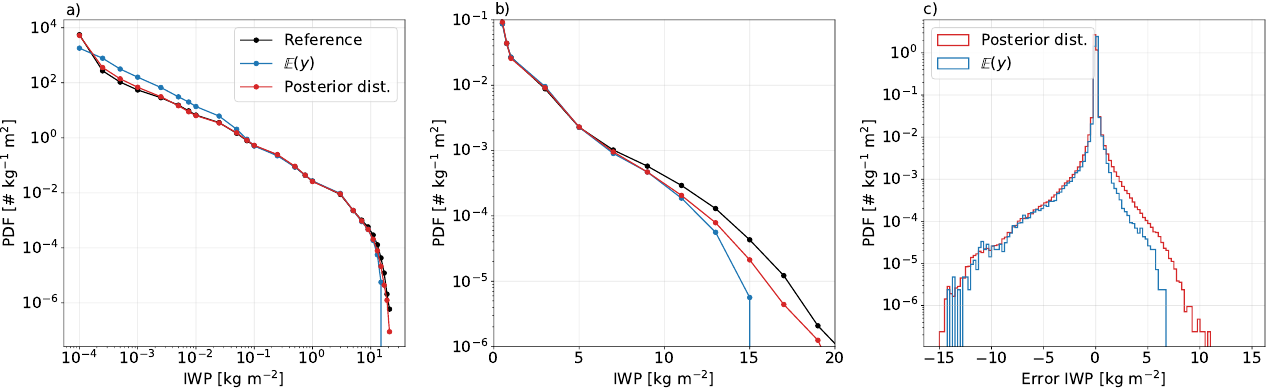
Figure 9. ( a ) The PDF of the retrieved and reference (test data) IWPs. The distribution of the random samples drawn from the posterior distribution is shown in red. The point estimates of IWP retrieval are represented by the expectation value (blue). ( b ) Same as ( a ), but zoomed in on the higher IWPs. ( c ) The error distribution. The data were from January